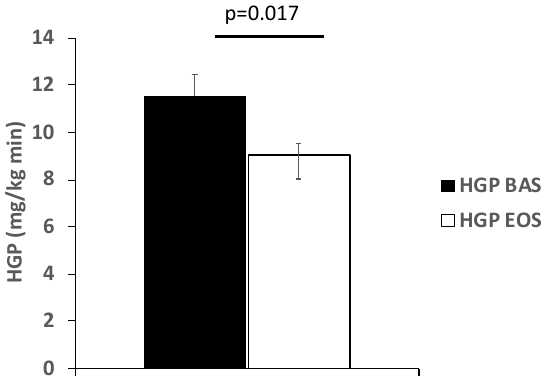
Figure 3. Fasting hepatic glucose production before (BAS) and after (EOS) 16 weeks of treatment with inhaled insulin.